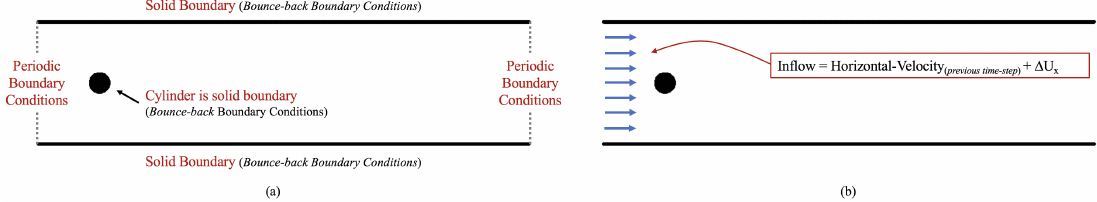
Figure 33. The geometrical setup for flow past cylinders using the Lattice Boltzmann method. ( a ) The boundary conditions specified on all sides of the domain and on the cylinder within the channel and ( b ) the inflow condition.